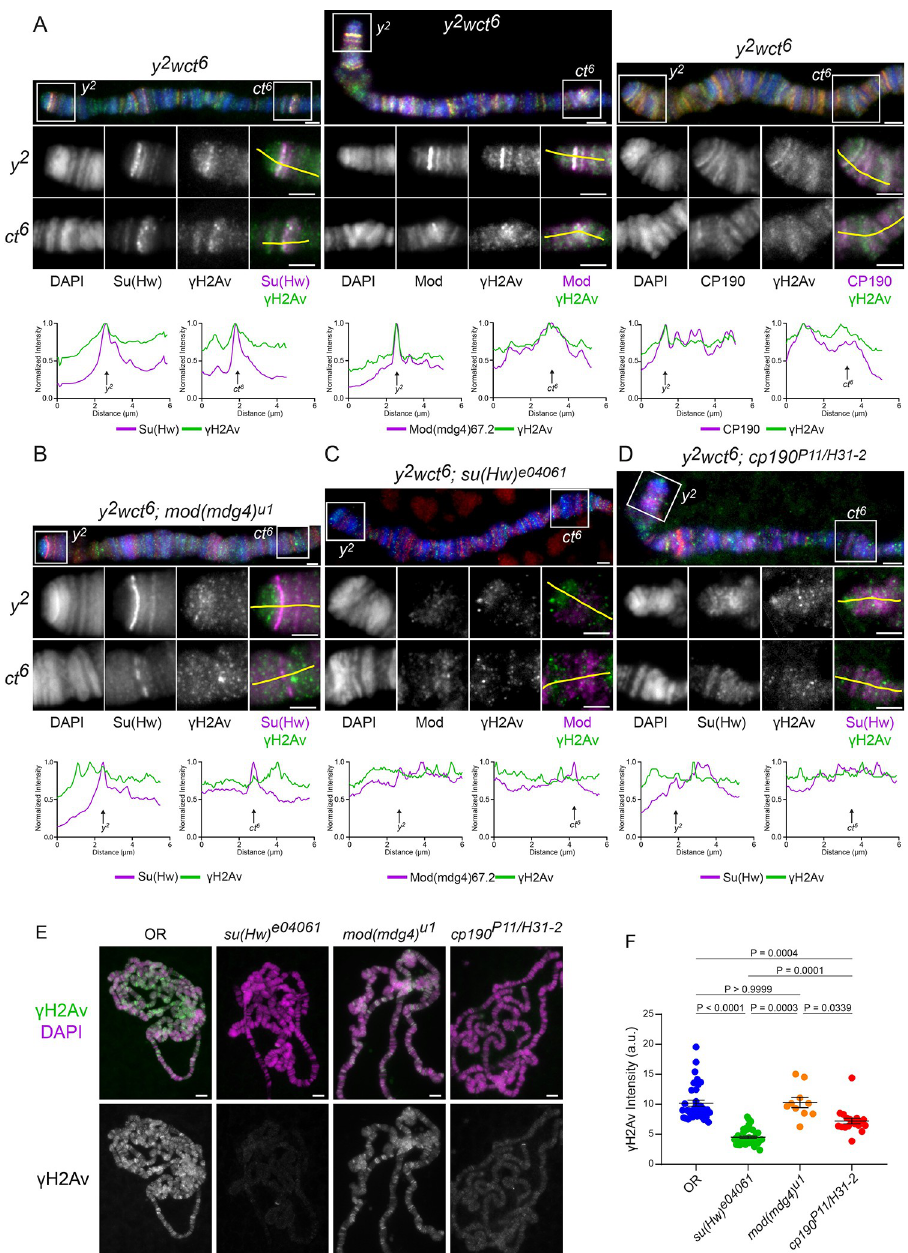
Fig 2. Phosphorylated H2Av is present at gypsy insulator sites and γ H2Av levels are significantly reduced in insulator protein mutants. A. Colocalization between γ H2Av and Su(Hw) (left), Mod(mdg4)67.2 (center), and CP190 (right) in a wild type y 2 wct 6 background. B. Colocalization between γ H2Av and Su(Hw) in a mod(mdg4) u1 homozygous background. C. Colocalization between γ H2Av and Mod(mdg4)67.2 in a su(Hw) e04061 homozygous background. D. Colocalization between γ H2Av and Su(Hw) in a cp190 P11/H31-2 trans -heterozygous background. Immunostaining results are shown of the X polytene chromosome from wandering third instar larvae in the y 2 wct 6 background. Each panel shows an X chromosome, with the y 2 and ct 6 sites labelled and delineated with white boxes. Beneath these are insets showing the y 2 and ct 6 sites in detail. Insets are shown as RGB merge, with DAPI on the blue channel, γ H2Av on the green channel, and various insulator proteins on the red channel. Red and green channels are shown independently in grey scale and merged as magenta and green. Beneath the insets are linescans corresponding to the yellow lines in the merged insets. Arrows represent the approximate sites of each gypsy locus. Scale bars are 2 μ m in the main figures and insets. Linescan intensities were normalized by dividing each value by the maximum intensity recorded on each channel. E. Immunostaining of polytene chromosomes from wandering third instar